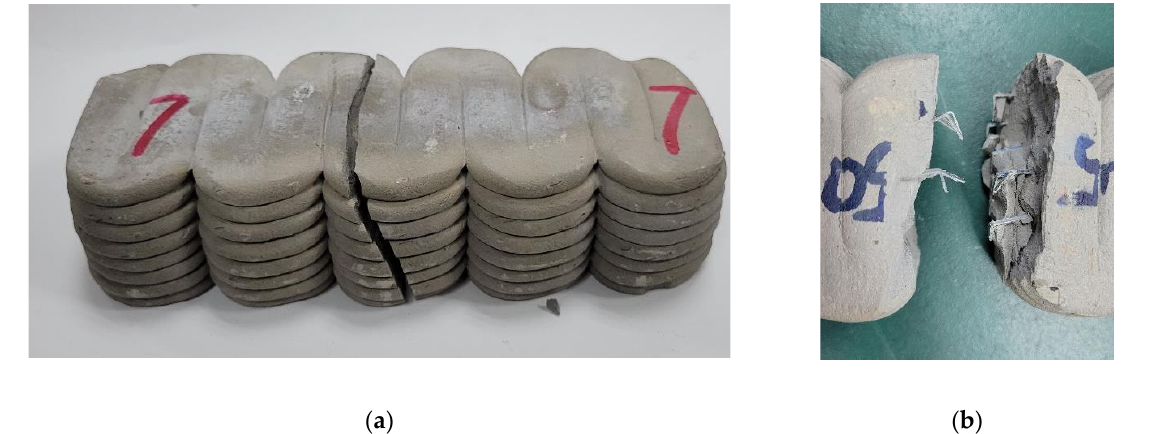
Figure 15. Failure of the IL- samples: ( a ) a neat break of IL-0 samples without staples, ( b ) regular